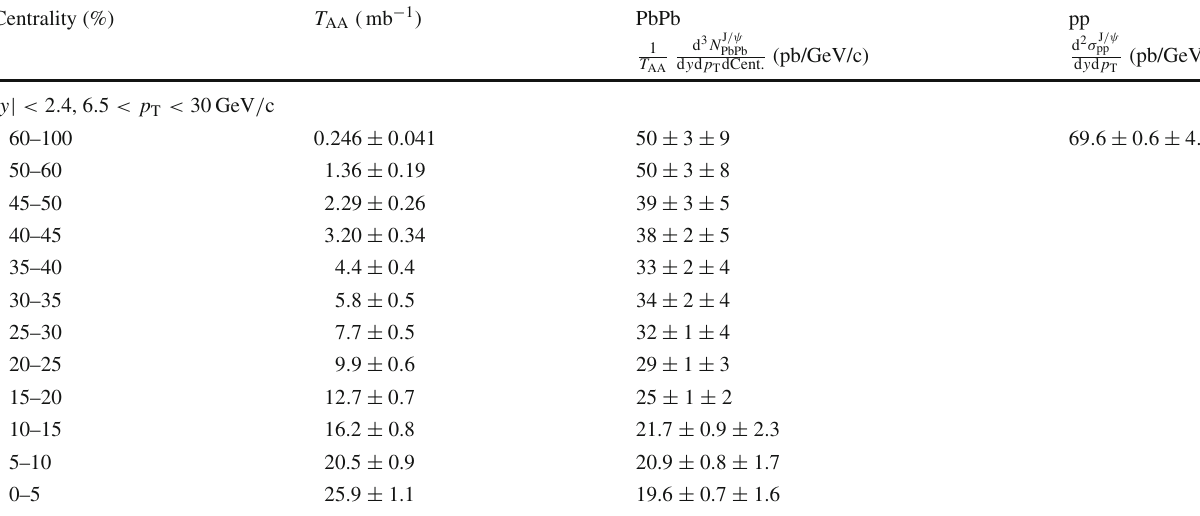
Table 1 The prompt J /ψ fiducial cross section in bins of centrality, measured in PbPb and pp collisions at 2.76TeV within the muon accep- tance defined by Eq. (4), and the nuclear overlap function ( T AA , with its systematic uncertainty). Listed uncertainties are statistical first and sys-